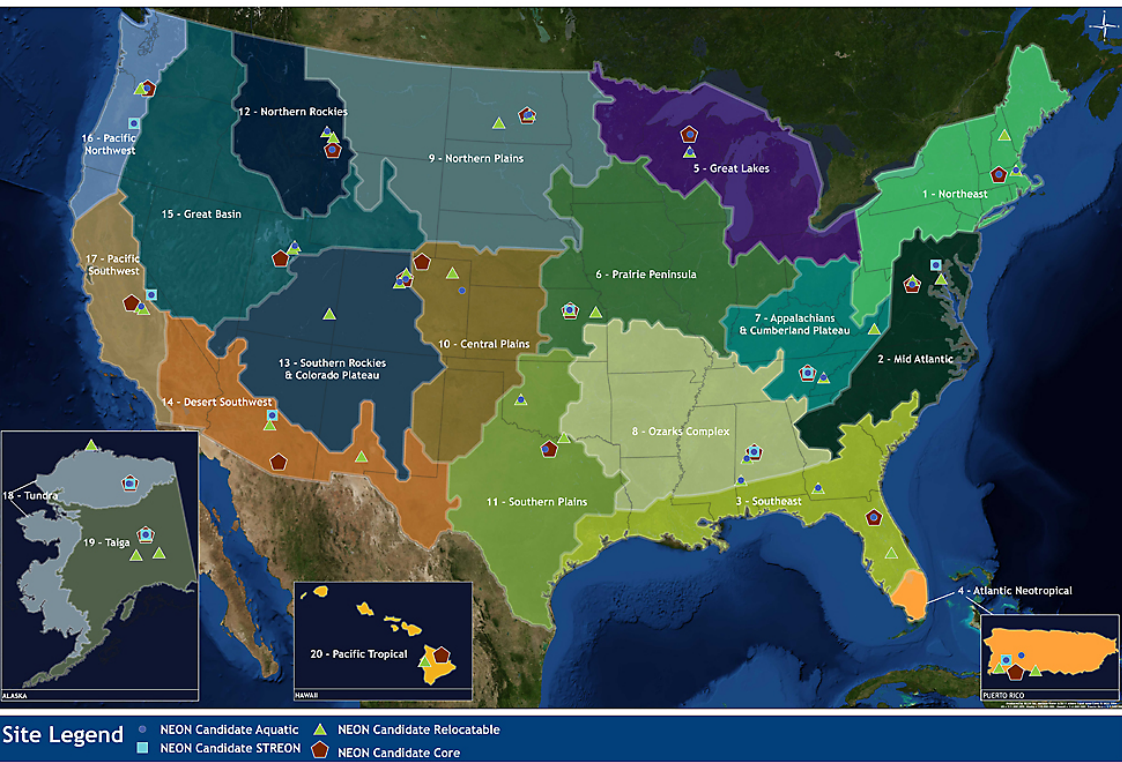
Fig. 1. NEON’s 20 eco-domains and their associated ecological research sites. “Core sites” monitor the ecosystem continuously for 30yr while “relocatable sites” are moved every 5–10yr in order to address specific research questions in a given domain. Some aquatic sites also include an embedded experiment called STREON (see the NEON Science Strategy document for more details; Schimel et al.,